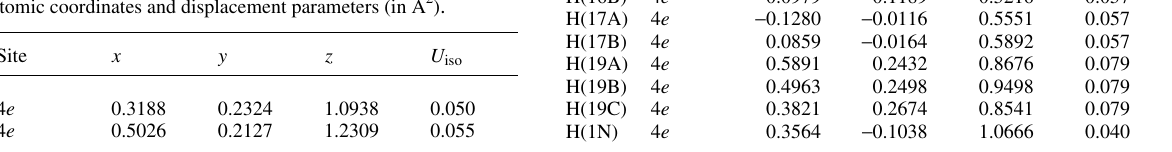
Table 2. Atomic coordinates and displacement parameters (in Å 2 ) .